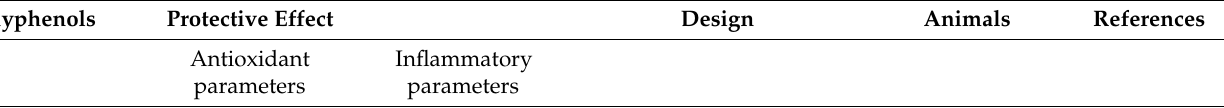
Table 2. Antioxidant and anti-inflammatory effects of